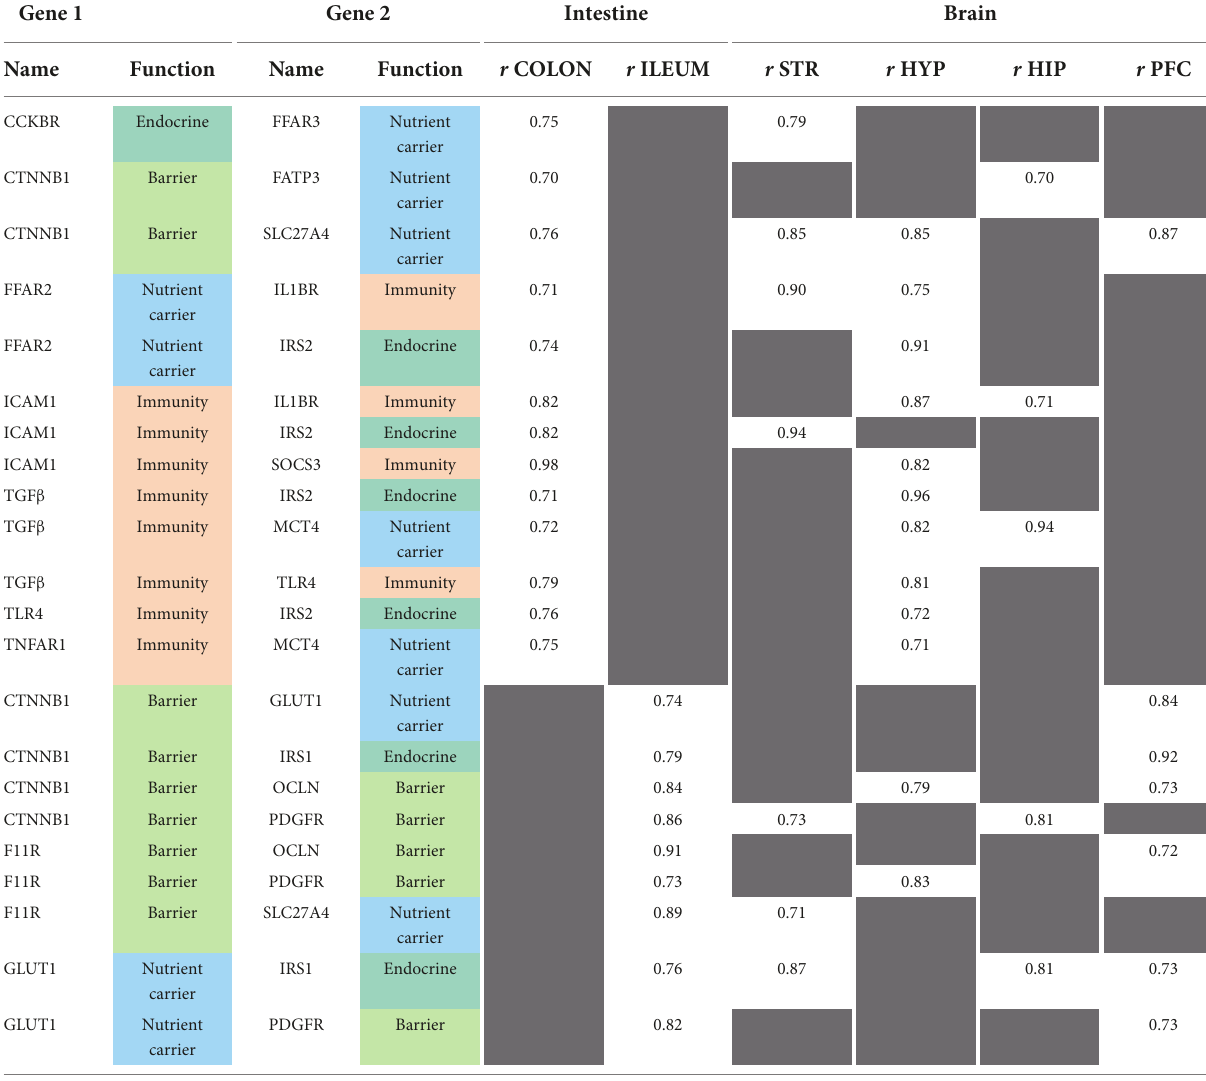
TABLE 7 List of pairs of genes for which their expression was highly correlated ( r > 0.7; P < 0.05) within the intestine and the brain. Gene 1 Gene 2 Intestine